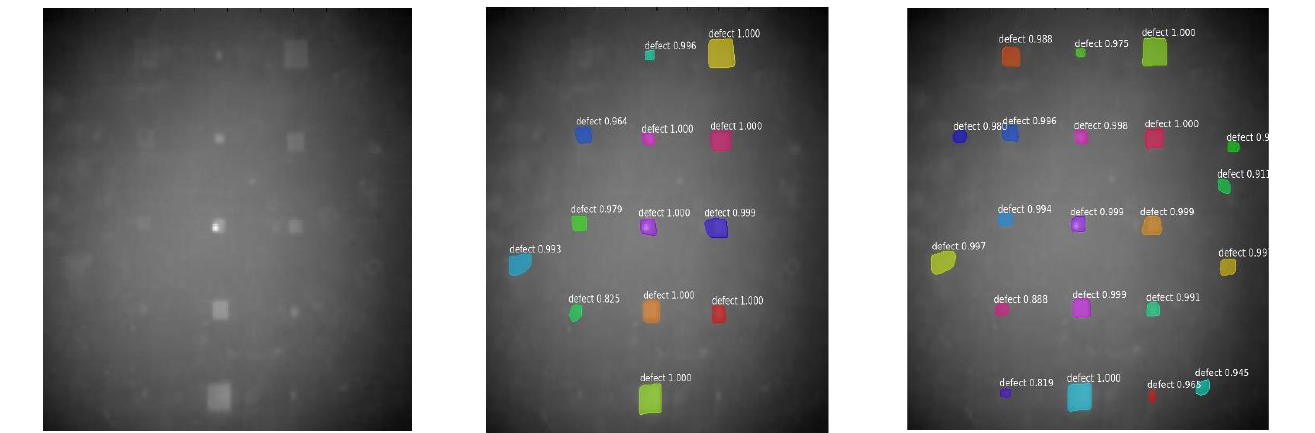
with synthetic data)